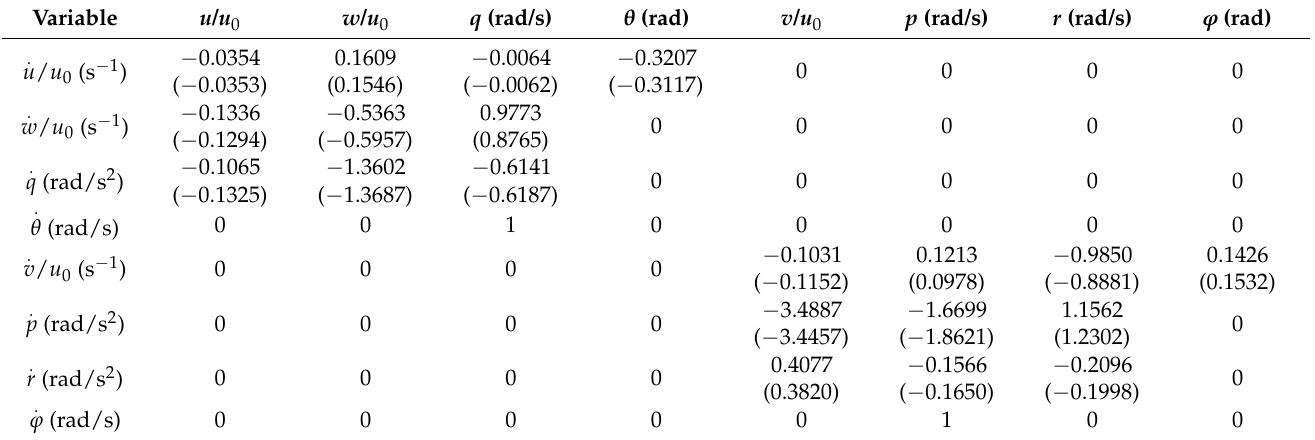
Table 21. CFD–RANS (extrapolated) 8 × 8 stability matrix for flight condition 15 in Tables 4 and 22 (reference takeoff case).